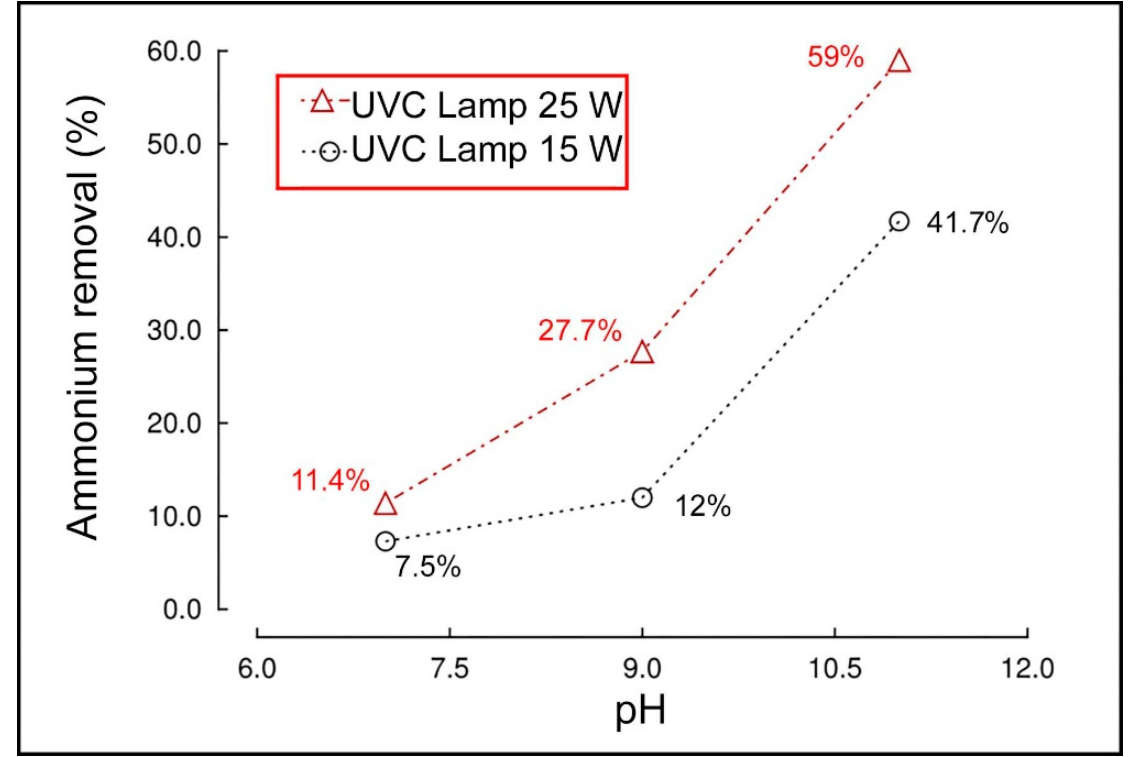
Figure 4. Dependence of NH 4+ /NH 3 removal performance (at 7 h), by photocatalysis, on pH (7.0–11.0) and lamp irradiation power (15 W, 25 W). Q = 1000 L/h, temperature = 20 ± 1 °C.